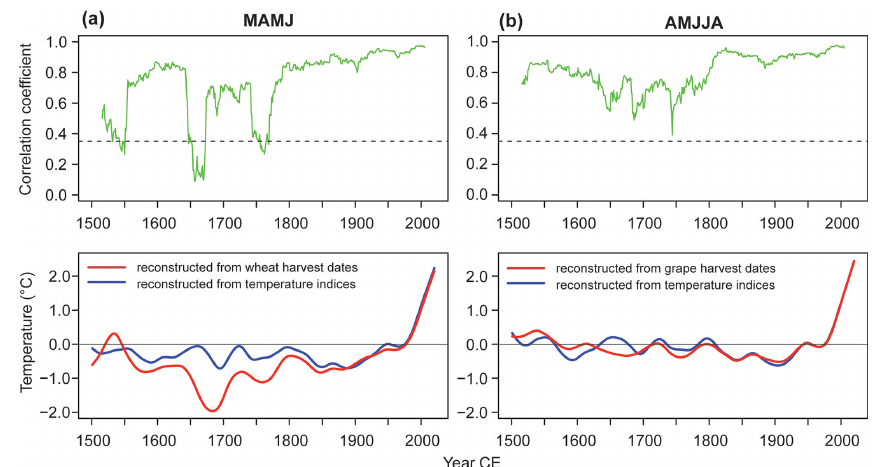
Figure 8. (a) The 31-year running correlations (top) and low-frequency signal expressed as smoothed series by the 60-year spline function (bottom) compared to MAMJ temperatures reconstructed from the wheat harvest dates (Možný et al., 2012) and those reconstructed from temperature indices. (b) The same as (a) but for AMJJA temperatures reconstructed from the grape harvest dates (Možný et al.,